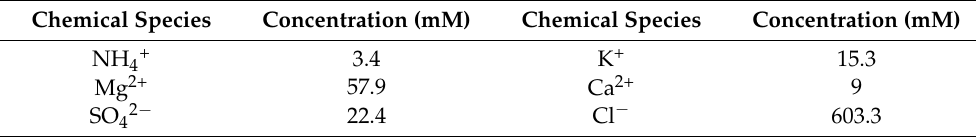
Table 1. The composition of artificial pore water. Chemical